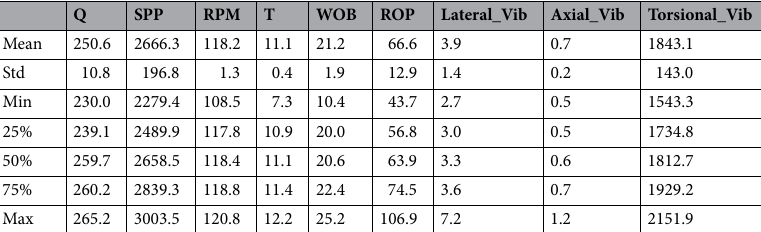
Table 1. Statistical analysis for the models’ data